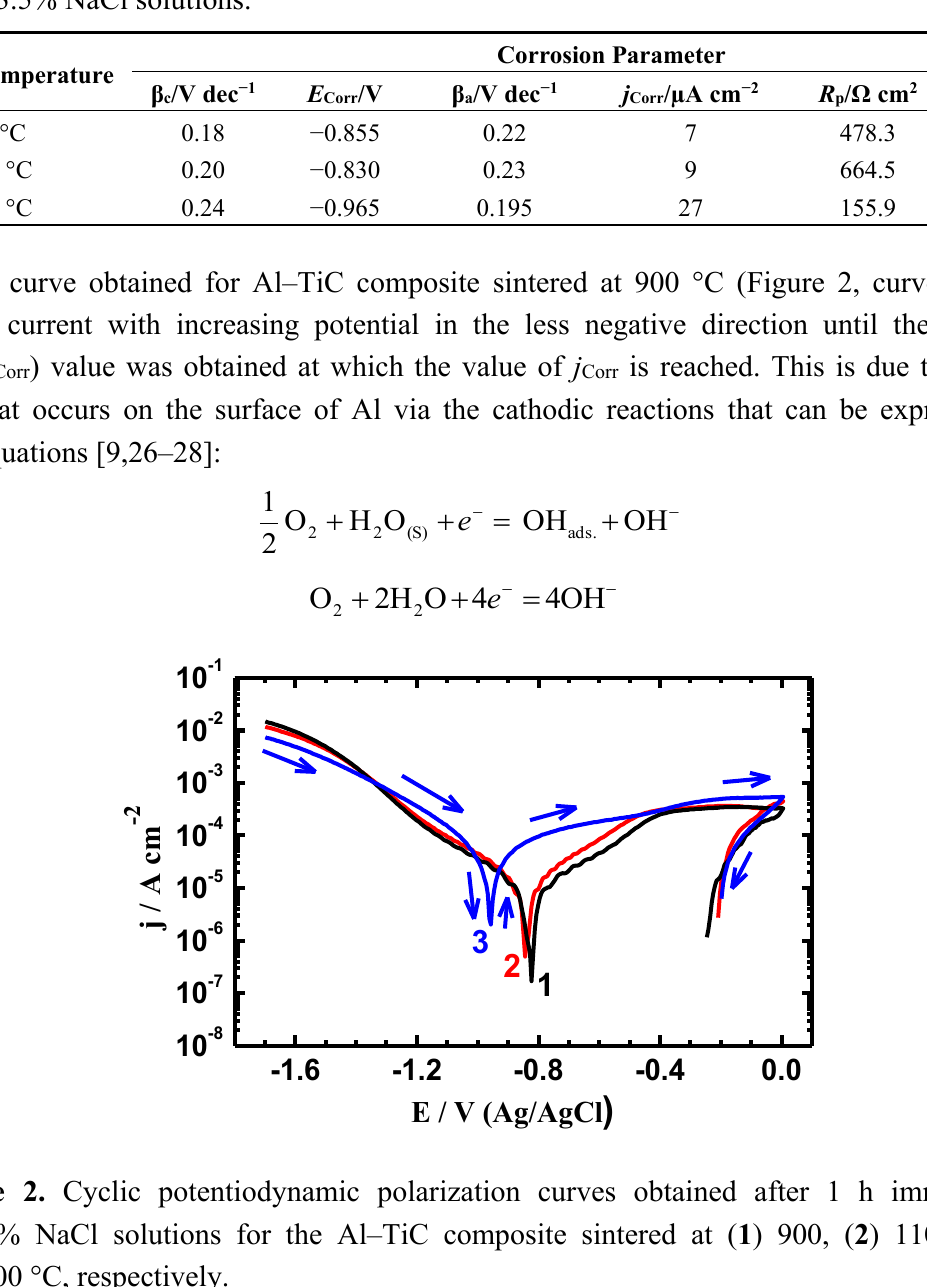
Table 1. Parameters obtained from the polarization curves for the different Al composites in the 3.5% NaCl solutions.